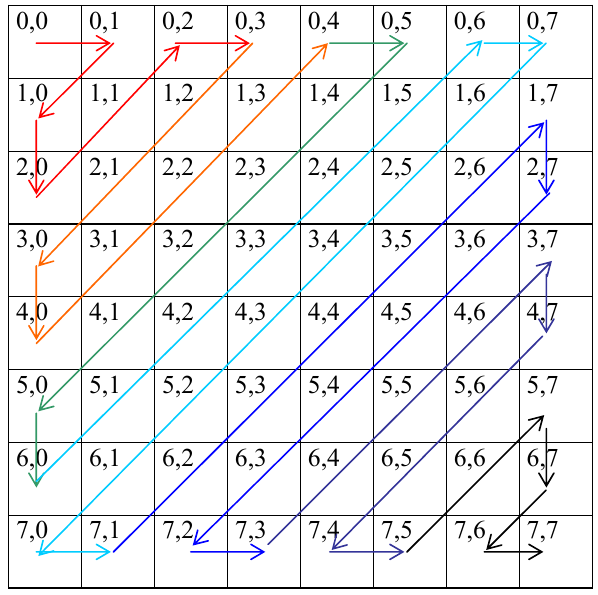
Fig. A2. Bit stream treatment of an 8 × 8 image. Figure A2. Bit stream treatment of an 8x8 image